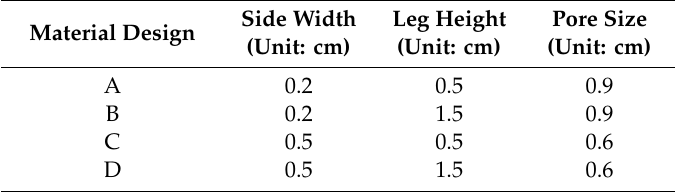
Figure 1. Technical material design according to di ff erent side widths, leg heights, and pore sizes. Table 1. Nomenclature for the technical material